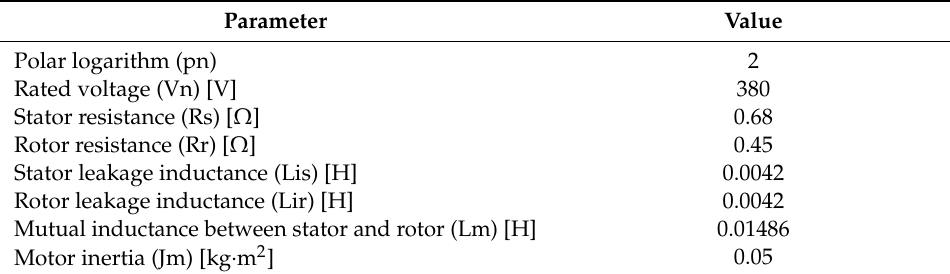
Table 1. Parameters of the asynchronous motor.